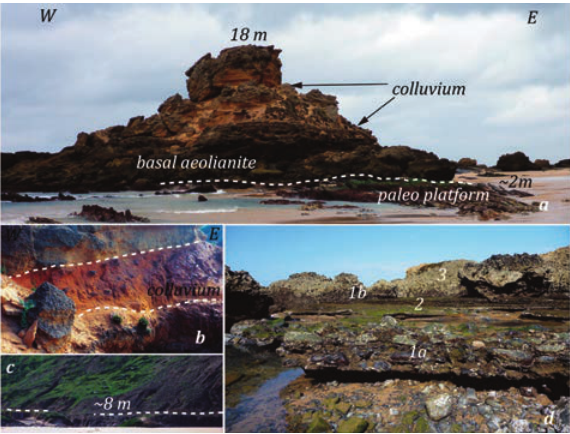
Figure 6. Marine terraces at the Castelejo site. Location is given in Figure 2. a) Perspective of the aeolianites unit which lays on top of a paleo wave-cut platform; b) Detail of a colluvium wedge with soil development inter bedded with aeolianites. c) fluvial terrace at 8m; d) Sedimentary sequence on top of the paleo platform: 1a-basal coarser unit; 2- sandy beach unit; 1b- upper coarser unit; 3-aeolian- ites.